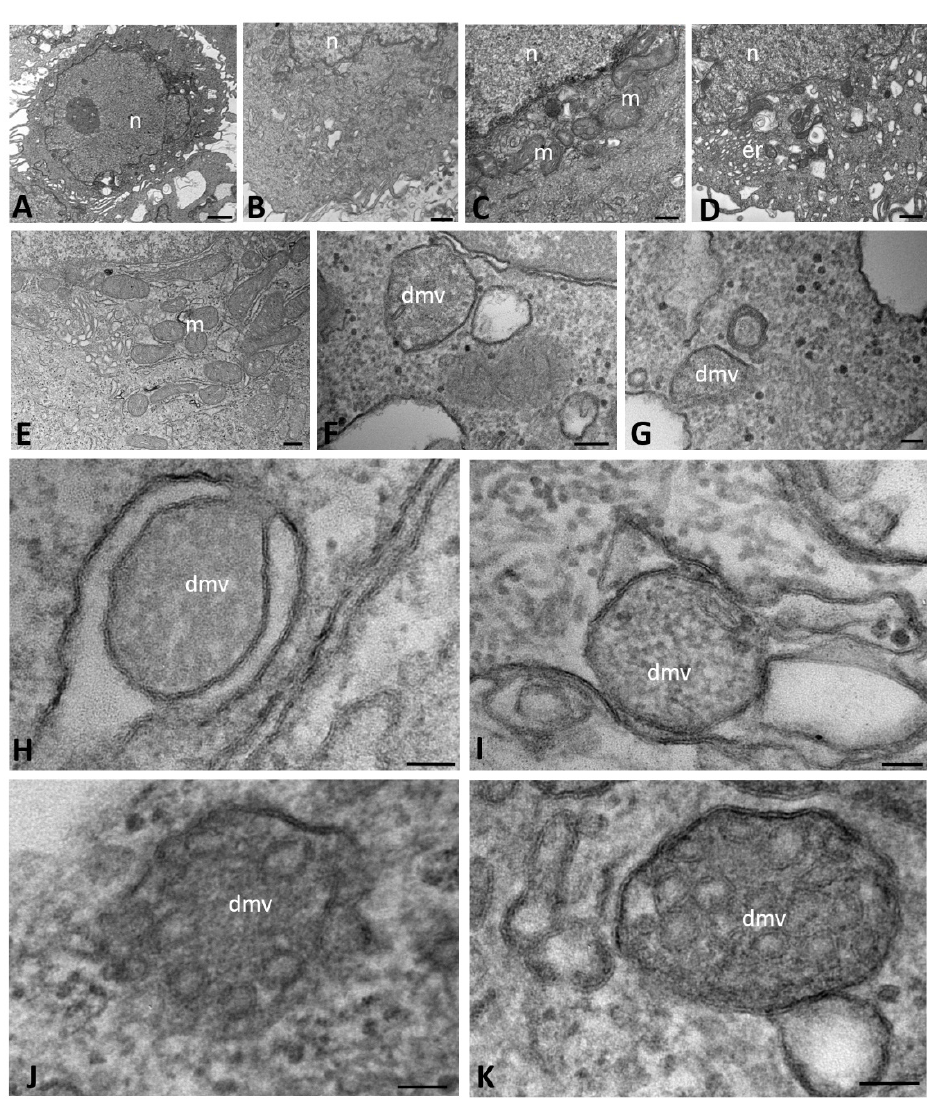
Figure 1. Transmission electron microscopy showing the morphology of mock-infected ( A – D ) and SARS-CoV-2-infected ( E – K ) CFBE41o- WT cells at early time points of infection (from 1 to 6 h post infection). Double-membrane vesicles with granular ( F – I ) and vesicular ( J , K ) content are visible. (dmv): double-membrane vesicles; (er): endoplasmic reticulum; (m): mitochondria; (n): nucleus. Bars: ( A ) 1 µm; ( B , D ) 500 nm; ( C , E ) 200 nm; ( F ) 100 nm; ( G – K ) 50 nm.